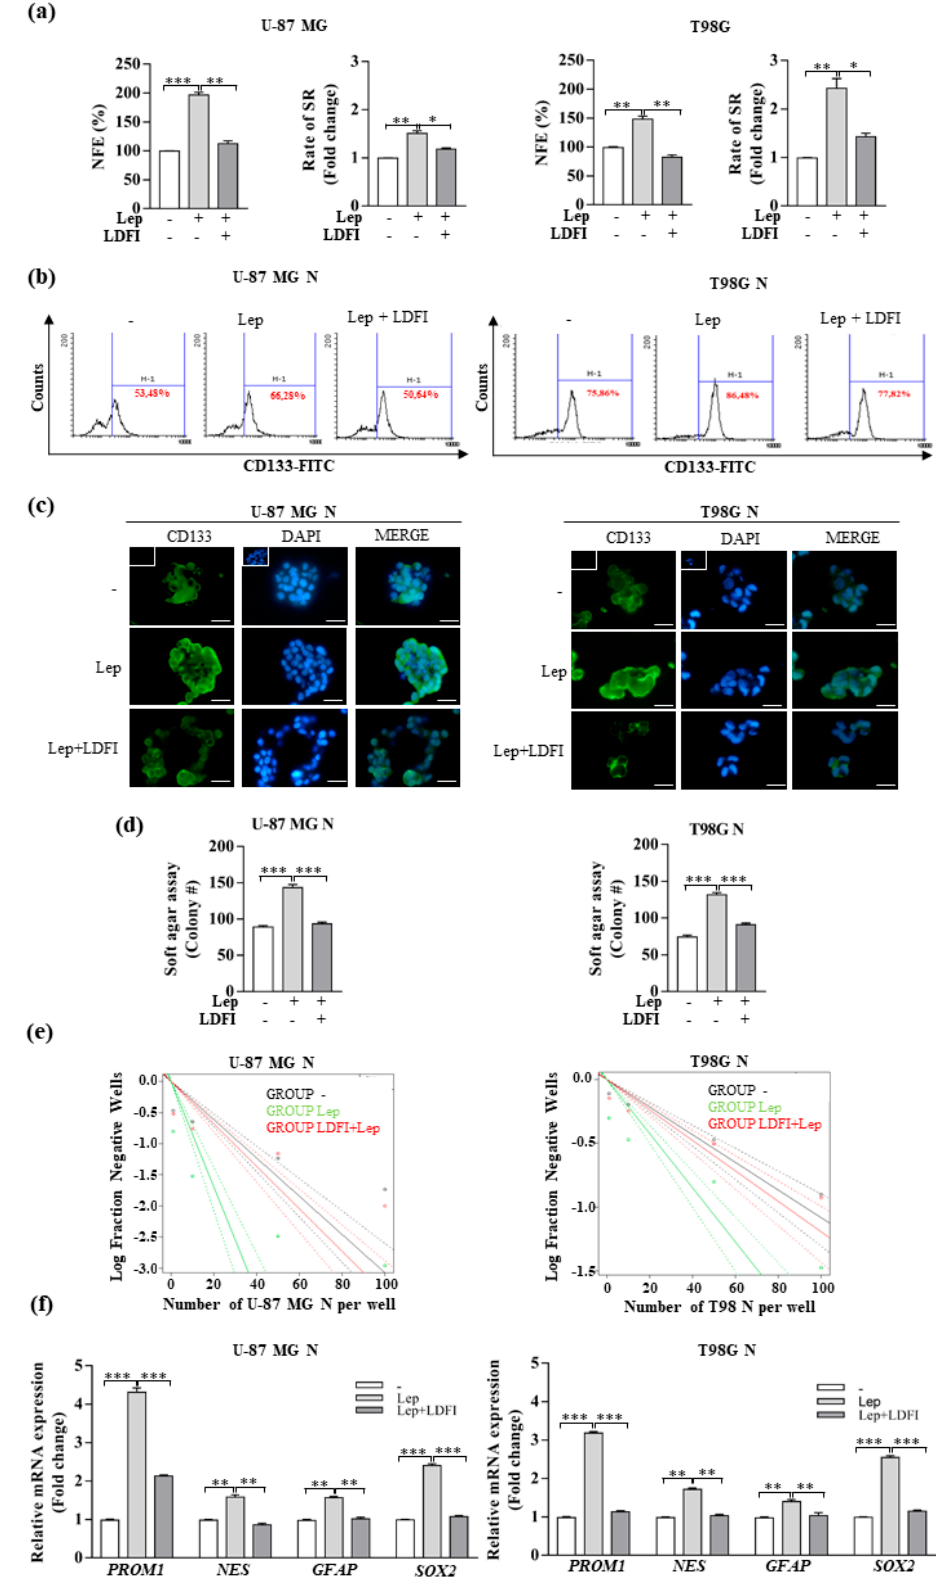
Figure 4. E ff ects of leptin on glioblastoma stem-like cell activity. ( a ) NFE and SR in U-87 MG and T98G Figure 4. Effects of leptin on glioblastoma stem ‐ like cell activity. ( a ) NFE and SR in U ‐ 87 MG and cells cultured as neurospheres (U-87 MG N and T98G N, respectively) in the presence of vehicle (-) T98G cells cultured as neurospheres (U ‐ 87 MG N and T98G N, respectively) in the presence of vehicle ( ‐ ) or leptin (Lep, 500 ng/mL) alone or in combination with the leptin antagonist (LDFI, 1 μ mol/L). ( b )